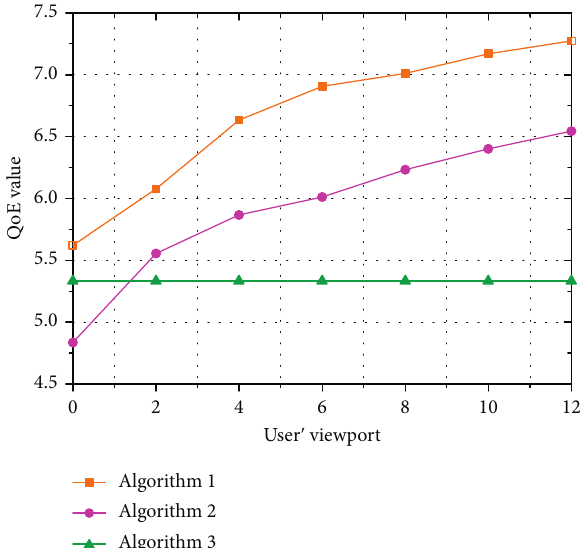
Figure 12: The relationship between the number of feedback user viewports and the QoE value of all